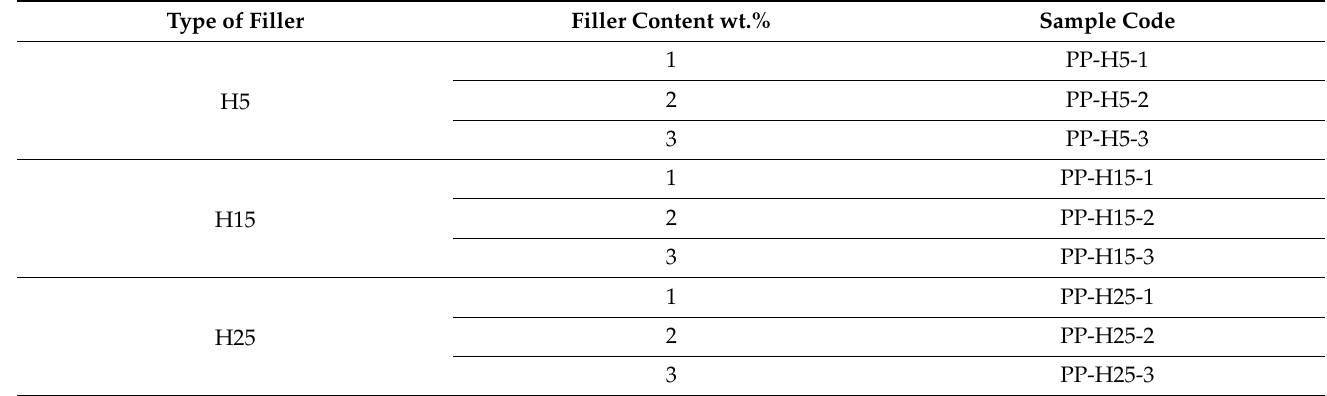
Table 2. Fabricated nanocomposites and test specimen